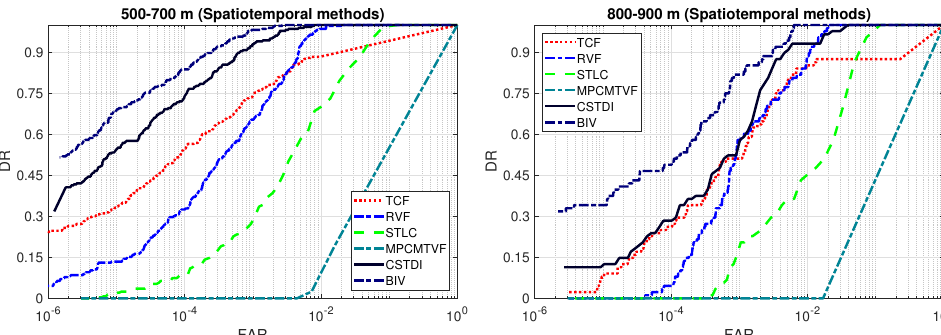
Figure 8. ROC curves comparison: spatiotemporal methods (logarithmic x-axis). Existing methods are outperformed by the BIV target detector on both